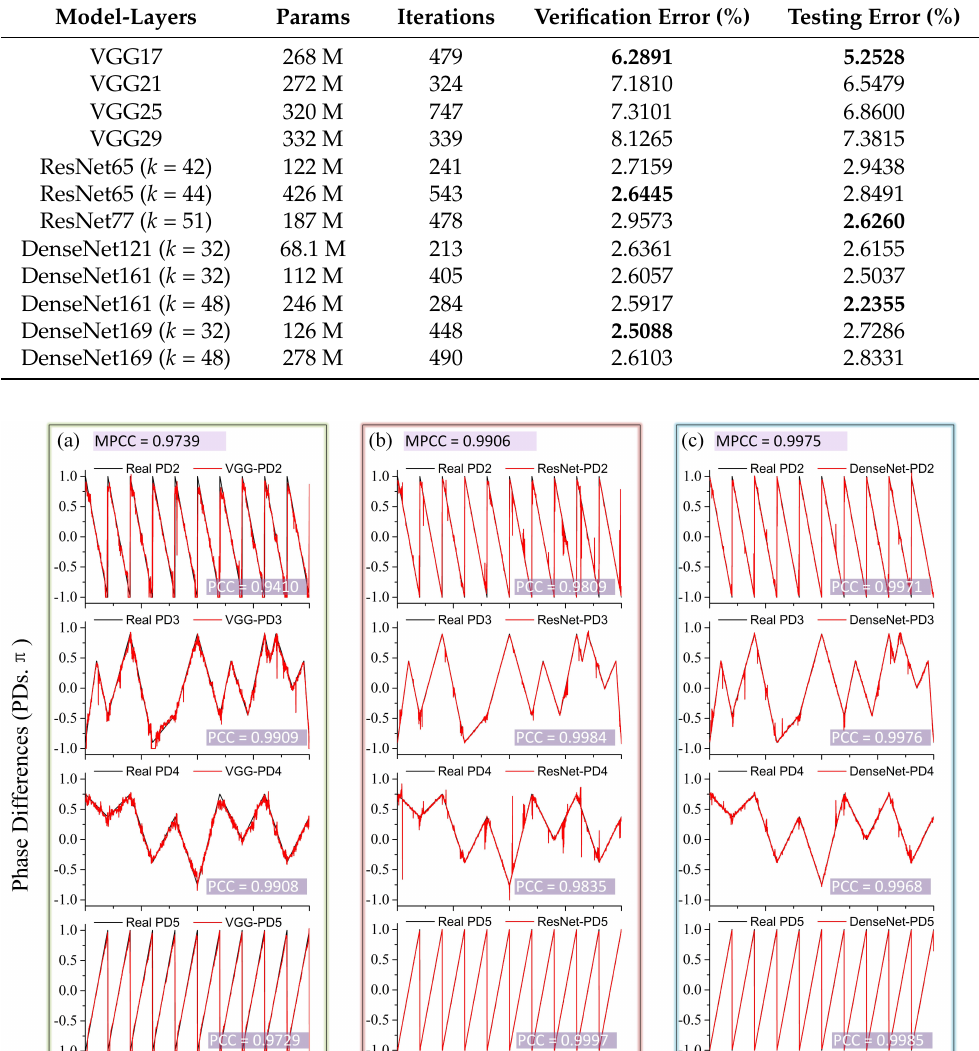
Table 1. Error rates (%) of single-model results on the TS-DFT interference spectra of five-soliton molecules datasets.